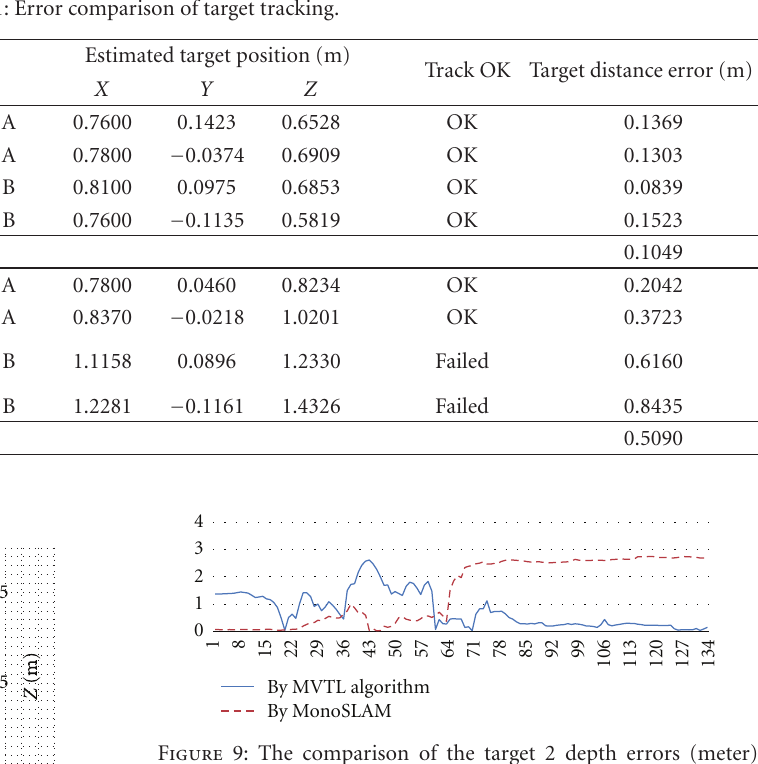
Table 1: Error comparison of target tracking.